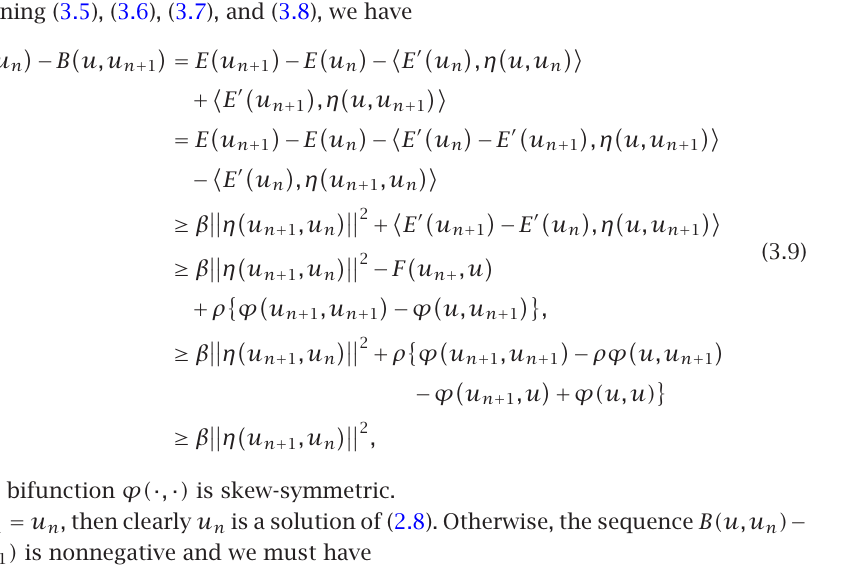
Algorithm 3.6 . For a given u iterative